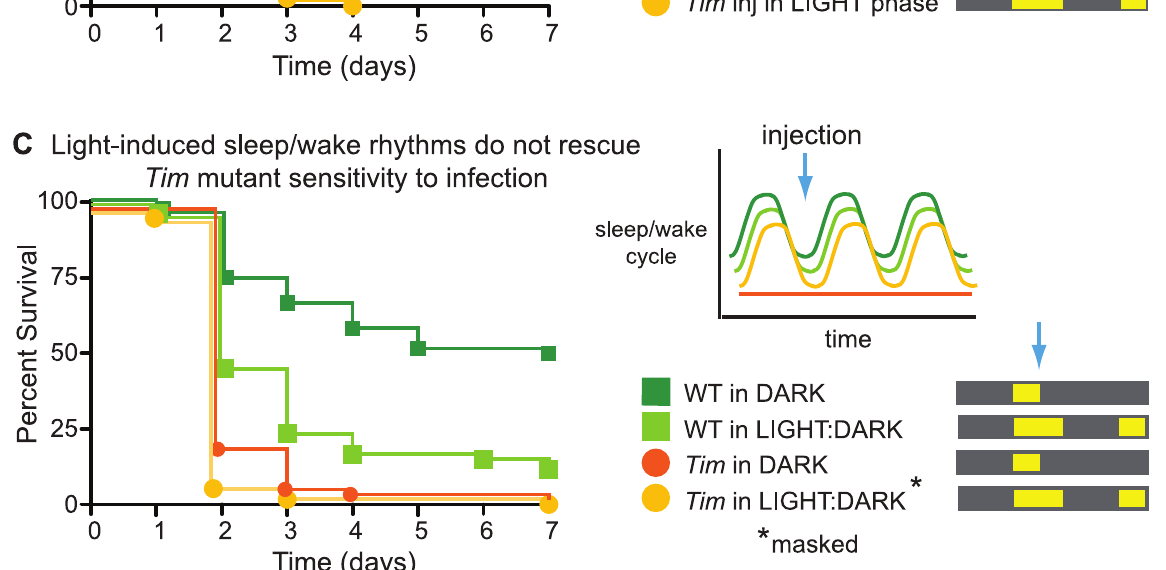
Figure 3. Resistance against S.pneumonia correlates with Tim activity. Shown here are Kaplan-Meier survival curves comparing wild-type flies and Tim mutants infected with S. pneumoniae and subjected to different light conditions as detailed in the schematic diagrams. (A) Light- induced degradation of Tim protein in wild-type flies results in increased sensitivity to S. pneumoniae . Infected wild-type flies incubated in constant light were more sensitive than wild-type flies incubated in darkness (p , 0.0001). Tim mutants incubated in constant light died as rapidly as did Tim mutants incubated in darkness (p=0.3404). (B) Wild-type flies were more sensitive to S. pneumoniae when infected at a time of day when Tim protein is low. Wild-type flies were less sensitive when infected 6 hours after lights off (DARK) than 6 hours after lights on, when Tim protein is minimally and maximally expressed, respectively (p , 0.0001). Tim mutant sensitivity was not rescued by infection 6 hours after lights off (DARK) (p=0.4134). (C) Light-induced sleep-wake rhythms (a startle response called ‘‘masking’’) do not rescue Tim mutant sensitivity to infection. Tim mutant sensitivity